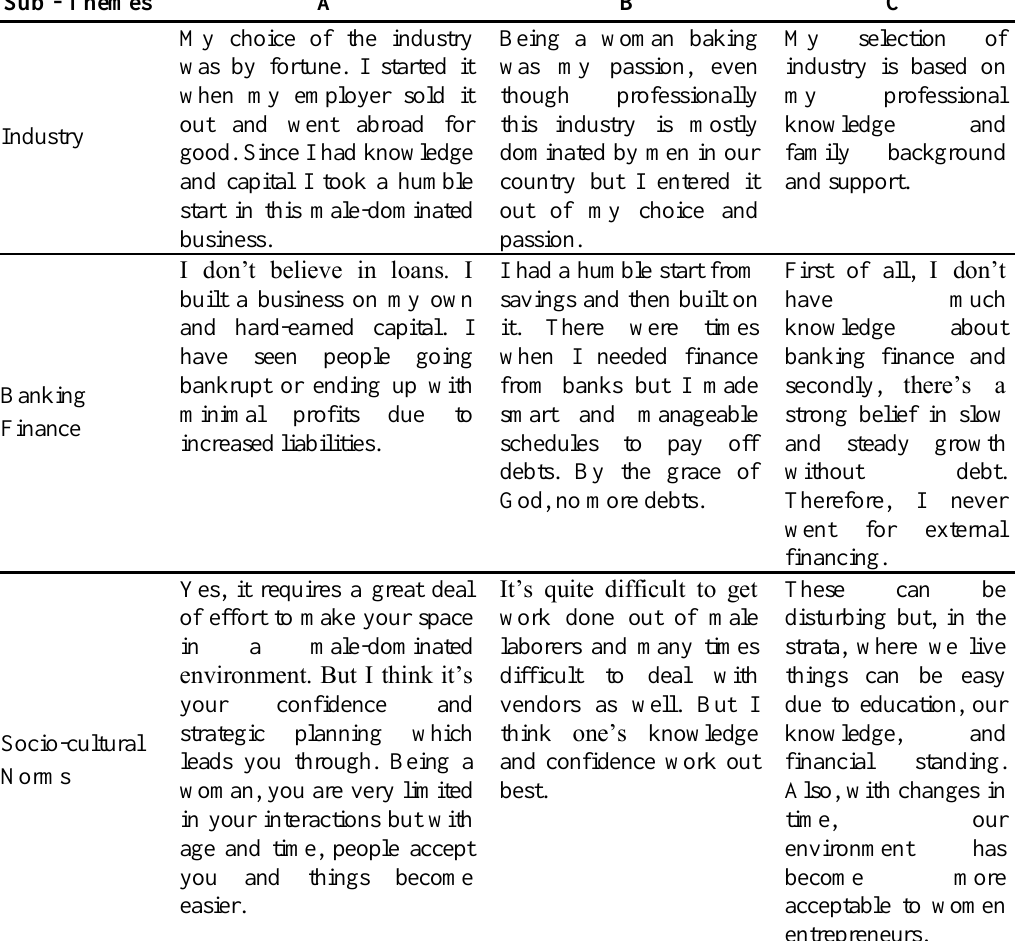
Table.5. Women’s Entrepreneurial Reflections on